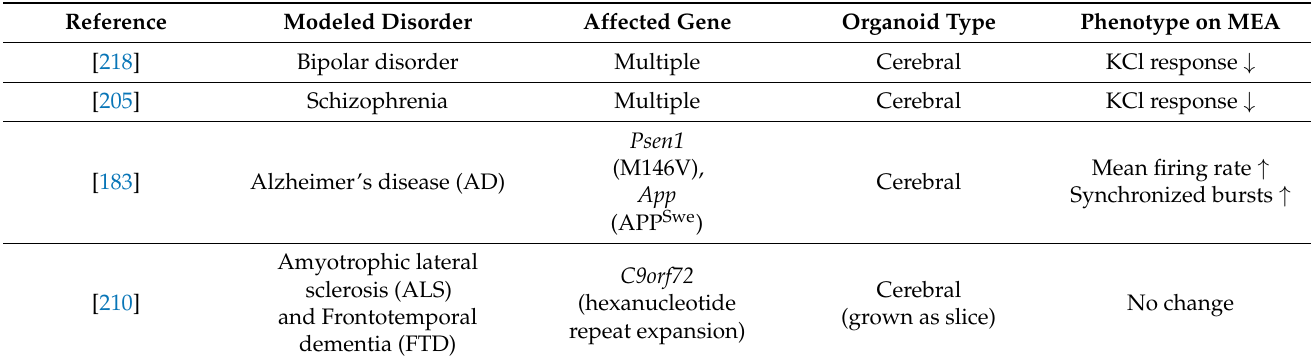
Table 2. hiPSC-derived genetic brain organoid models of psychiatric disorders and neurodegenerative diseases on